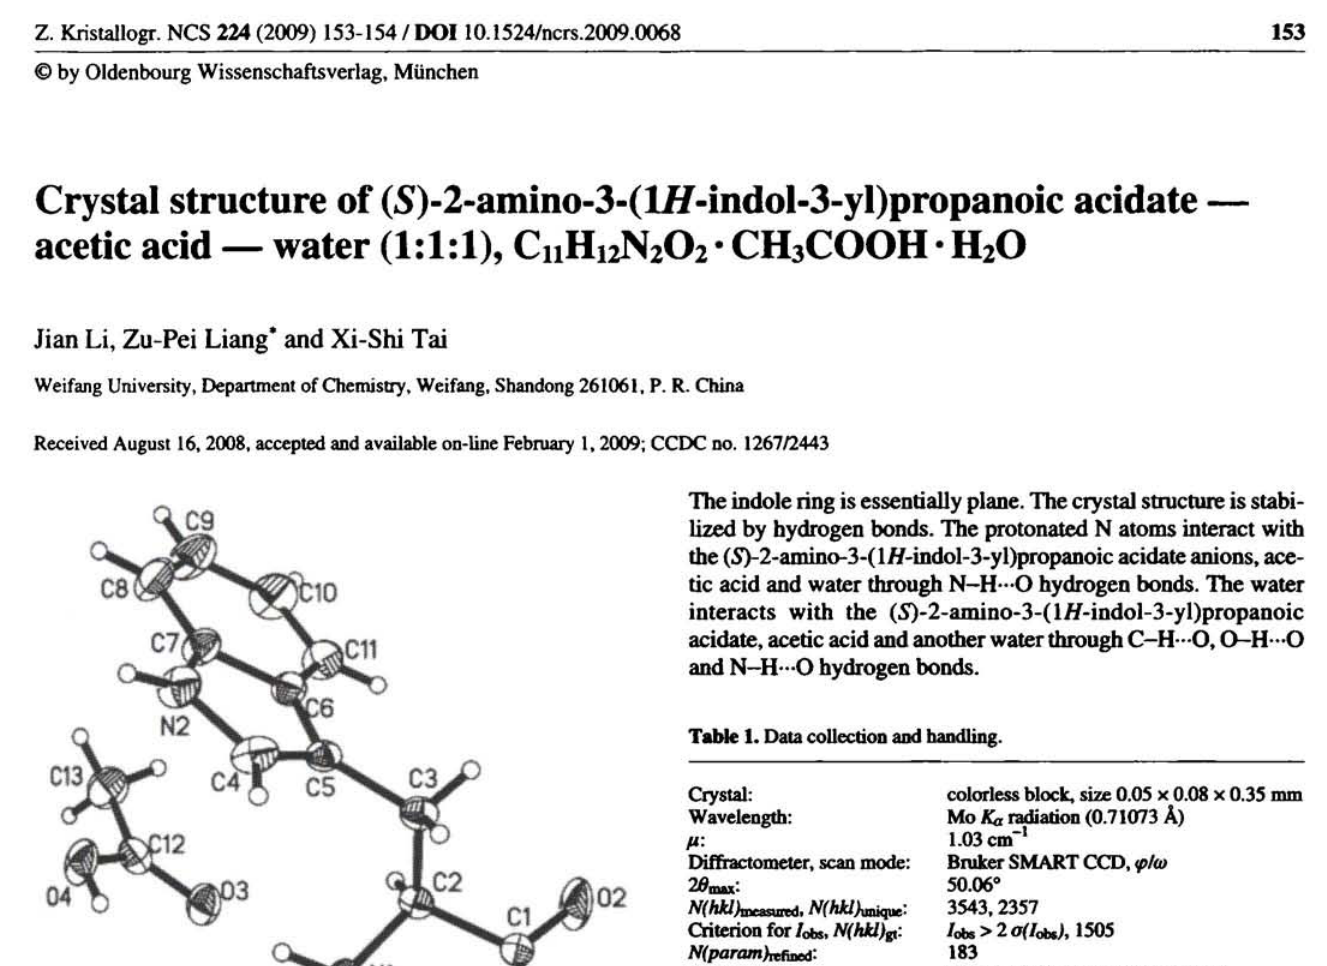
Table 2. Atomic coordinates and displacement parameters (in Â 2